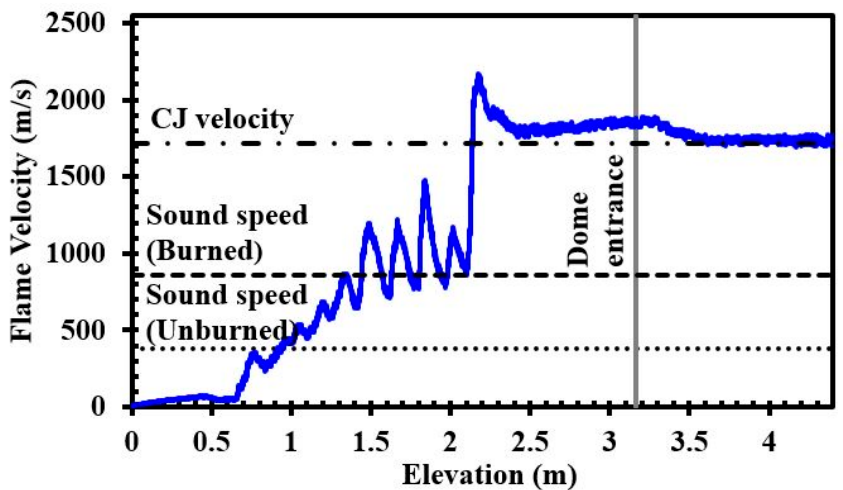
Figure 8. Flame velocity in H 2 –air mixture with 20% hydrogen concentration.